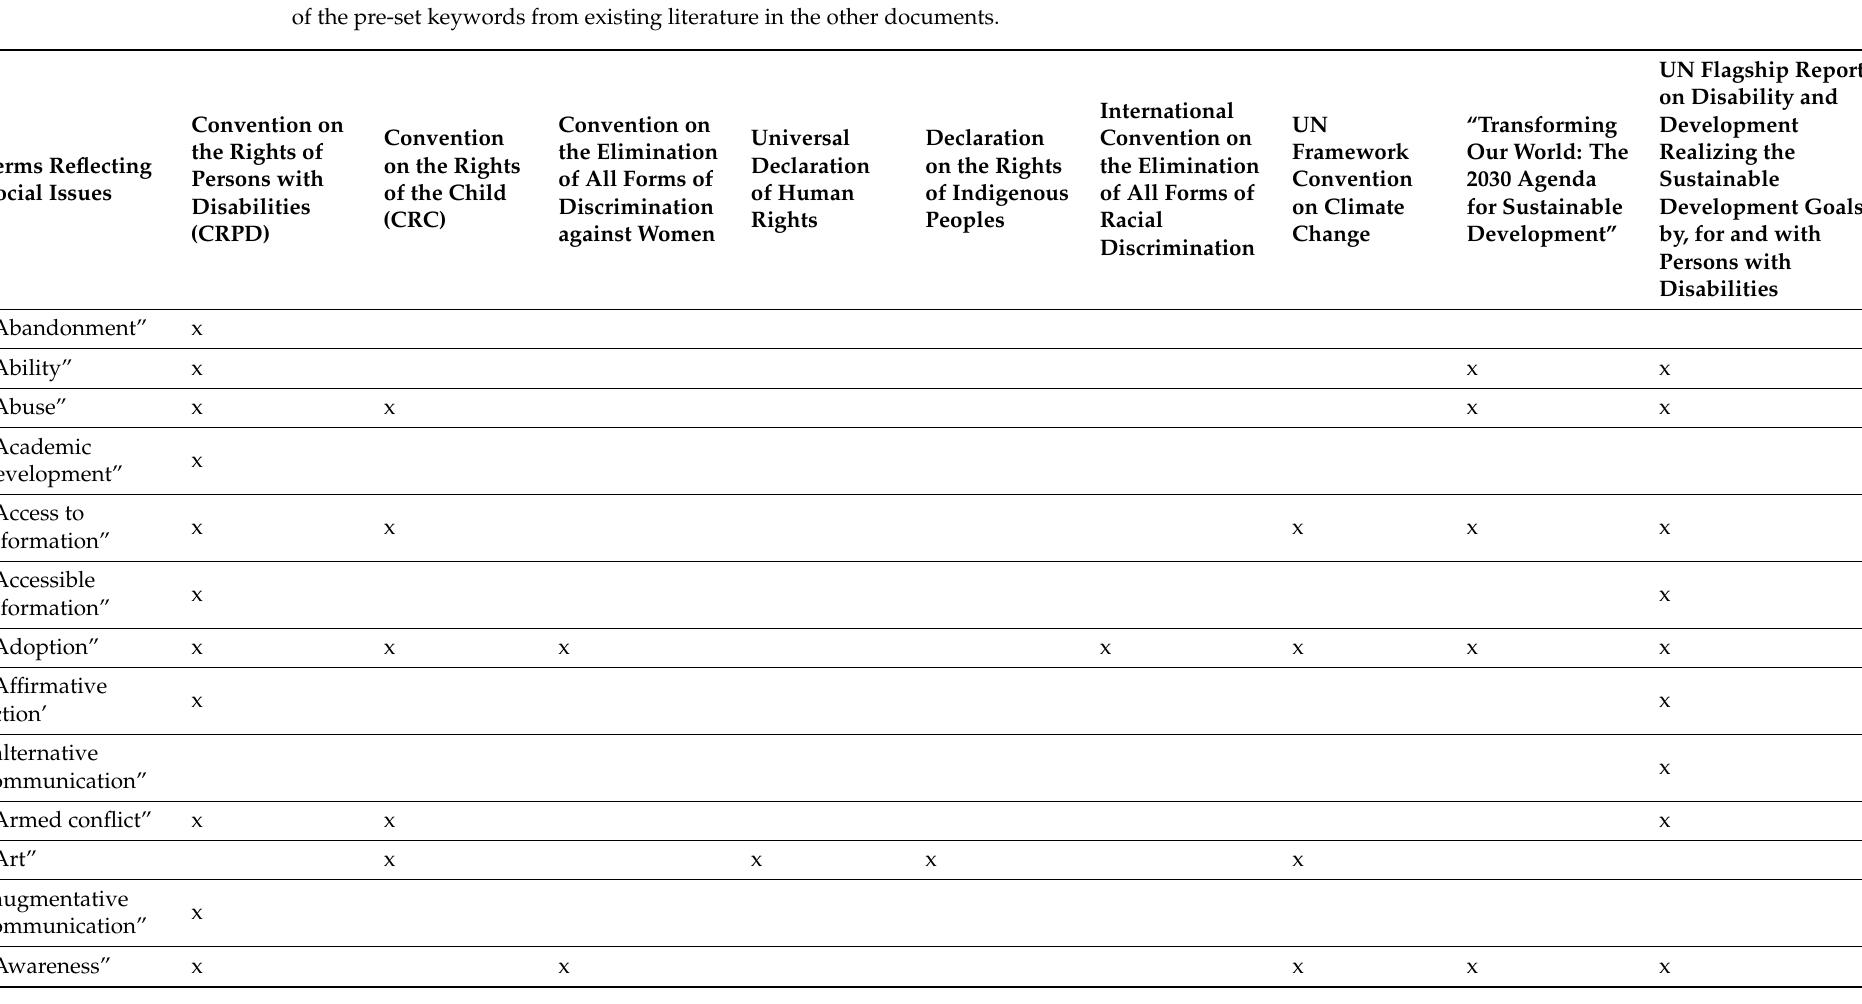
Table 15. Keywords of social issues identified from the Convention on the Rights of Persons with Disabilities (CRPD) document (Appendix A) not already in the list of the pre-set keywords from existing literature in the other